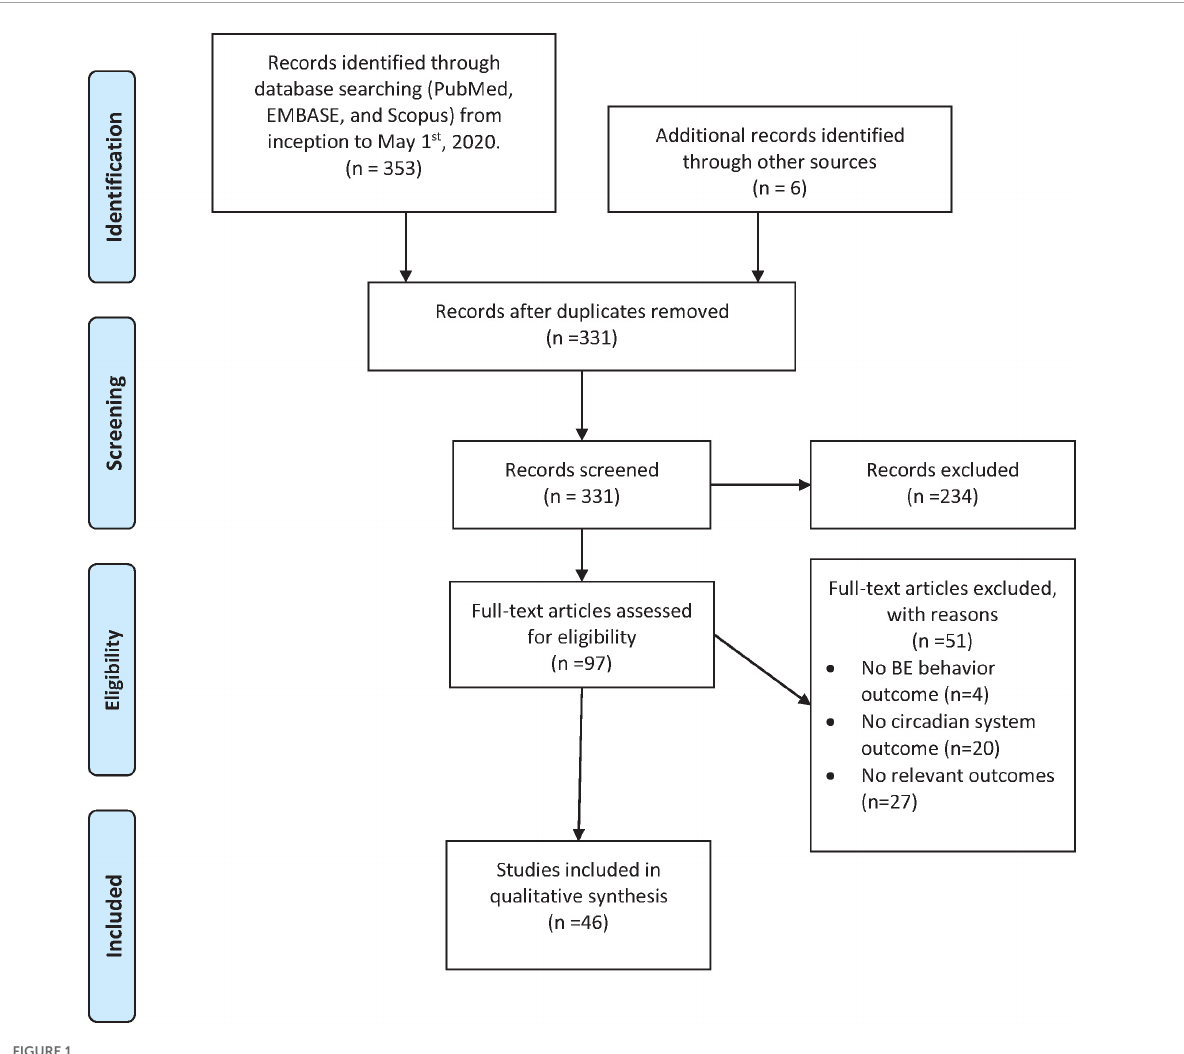
FIGURE1 PRISMA flowchart for observational